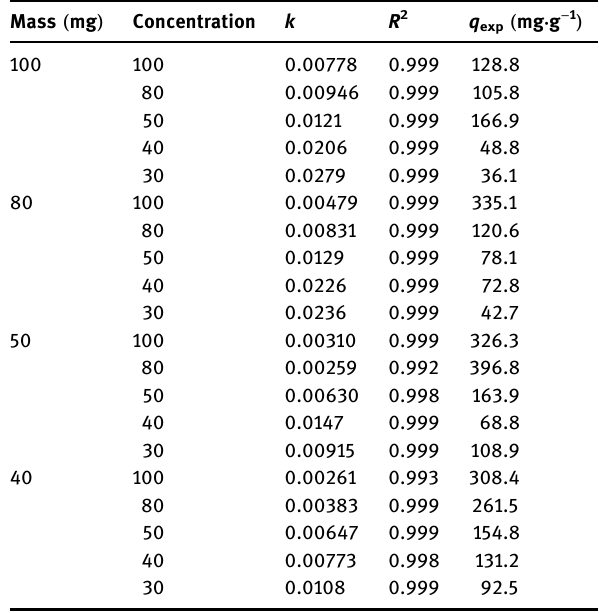
Table 2: Kinetic parameters for the adsorption of CR by the Sm - MOFs Mass ( mg )